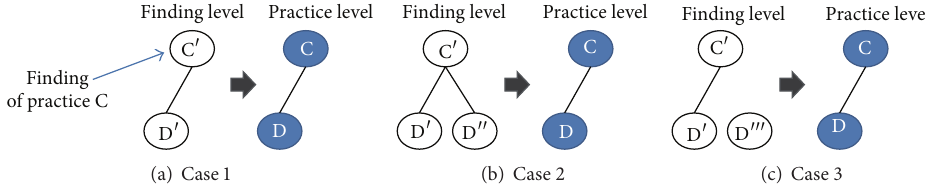
Figure 5: Correspondence between findings and